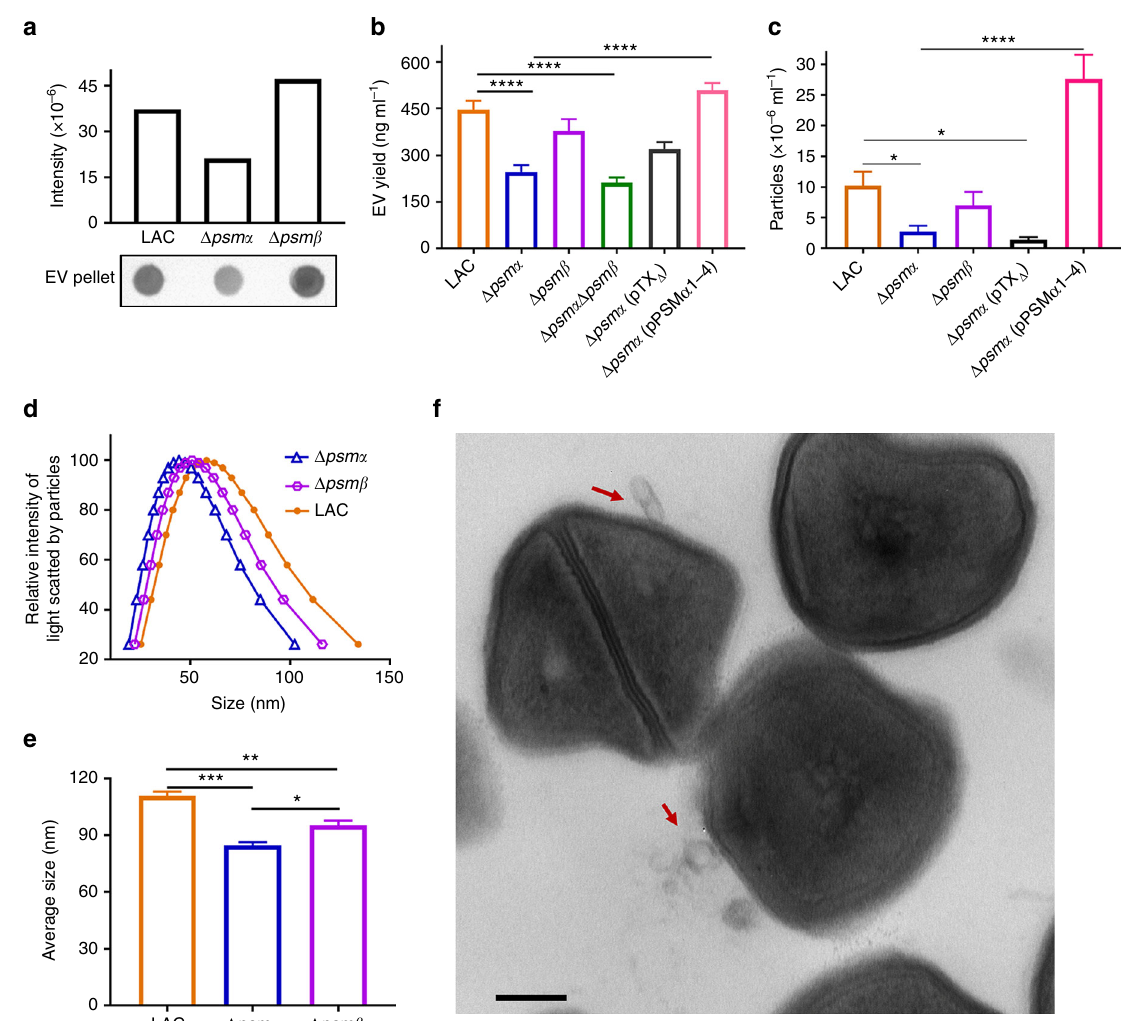
Fig. 2 Alpha-type phenol-soluble modulin peptides promote S. aureus EV production. a EV production from strain LAC and its isogenic mutants lacking psm α or psm β was evaluated by dot-blotting EV suspensions puri fi ed from the same volume of bacterial culture, b by quanti fi cation of total EV protein abundance, or c by direct EV quanti fi cation of EV particles with nanoparticle tracking analysis. d The size distribution and e average size of EVs puri fi ed from WT and Δ psm α and Δ psm β mutants were analyzed by dynamic light scattering, and the data were generated with ZataPALS particle sizing software. Dot-blotting was repeated at least twice, and a representitative result is presented. Signal intensity quanti fi ed by Image Studio Lite software is shown above the blot. EV quanti fi cation by other methods was calculated from at least three independent experiments and expressed as mean ± s.e.m. f An electron micrograph of WT strain JE2 carrying pTX Δ expressing the genes encoding PSM α 1-4 is shown. Scale bar, 200 nm. Samples were compared with a One- way ANOVA with Dunnett ’ s multiple comparison test (Fig. 2b, c) or with Tukey ’ s multiple comparison test (Fig. 2e). * P < 0.05, ** P < 0.01, *** P < 0.001, **** P <